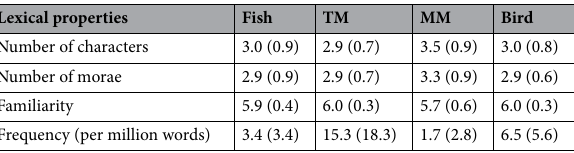
Table 3. Lexical properties of each category. Mean (SD). TM: terrestrial mammal; MM: marine